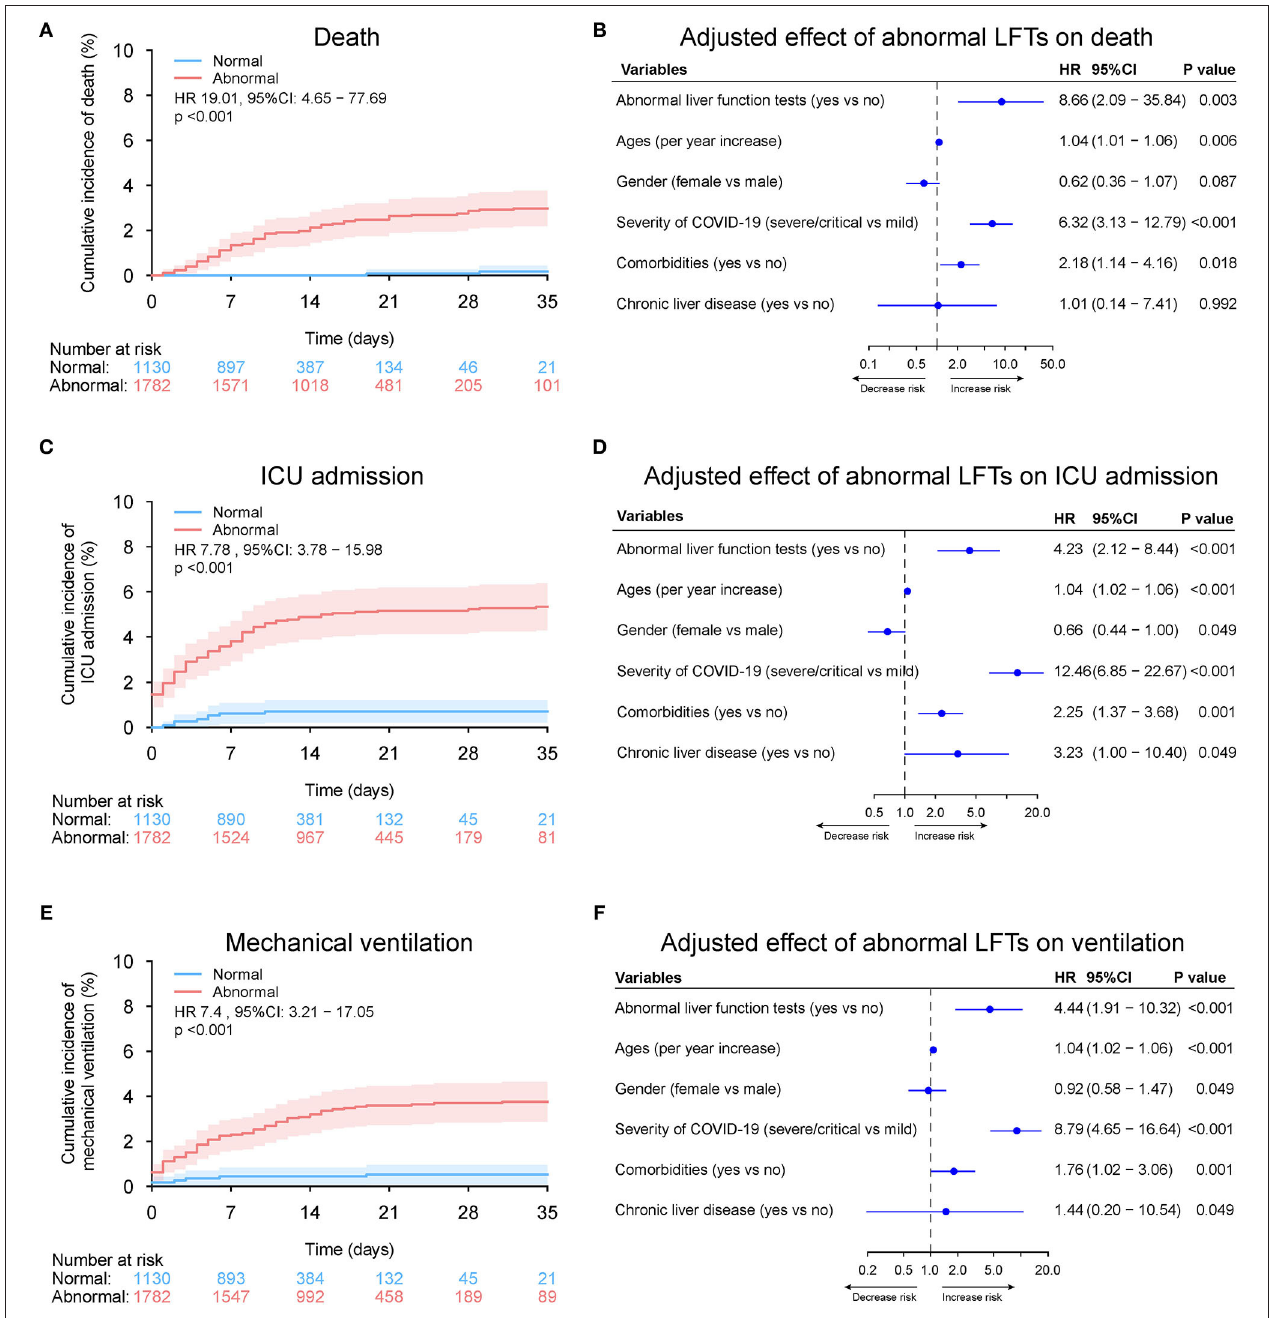
FIGURE 11 | Outcome analysis according to abnormal vs. normal liver function tests (LFTs) during hospitalization in entire cohort. (A) Cumulative incidence of death in patients with abnormal vs. normal LFTs during hospitalization in entire cohort. (B) Independent effect (hazard ratio with 95% confidence intervals) of abnormal vs. normal LFTs during hospitalization on all-cause mortality adjusted for potential confounders using the Cox multivariable regression models. (C) Cumulative incidence of ICU admission in patients with abnormal vs. normal LFTs during hospitalization based on competing risk approach (the Fine and Gray method) with death being the competing events. (D) Independent effect (hazard ratio with 95% confidence intervals) of abnormal vs. normal LFTs during hospitalization on ICU admission adjusted for potential confounders using the Cox multivariable regression models. (E) Cumulative incidence of mechanical ventilation in patients with abnormal vs. normal LFTs during hospitalization based on competing risk approach (the Fine and Gray method) with death being the competing events. (F) Independent effect (hazard ratio with 95% confidence intervals) of abnormal vs. normal LFTs during hospitalization on mechanical ventilation adjusted for potential confounders using the Cox multivariable regression models. Comorbidities include hypertension, cardiovascular disease, diabetes, chronic pulmonary diseases, cerebrovascular disease, malignancy, and autoimmune disease. Chronic liver diseases include hepatitis B virus infection, hepatitis C virus infection, and autoimmune liver disease. LFTs, liver function tests; ICU, intensive care